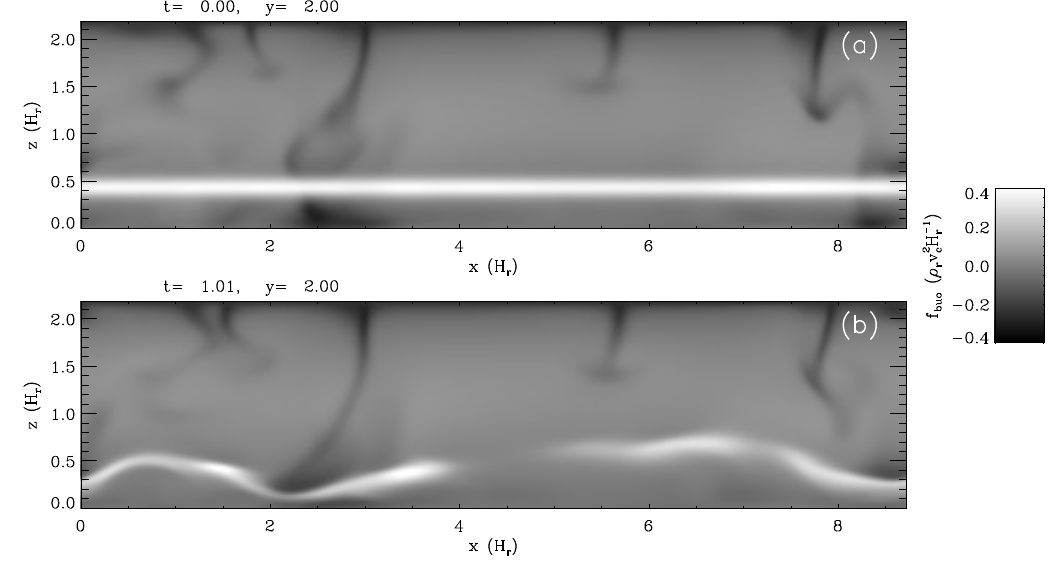
Figure 26: Vertical distribution of the buoyancy force (i.e., relative density perturbation) in a simulation of buoyant flux tubes interacting with ambient convective flows. Dark regions show antibuoyant downflows. The white horizontal structure in the top panel shows the initially horizontal flux tube. In a later snapshot (lower panel), two portions of the tube are seen to be pinned down by downflows. Image reproduced with permission from Fan et al. (2003), copyright by